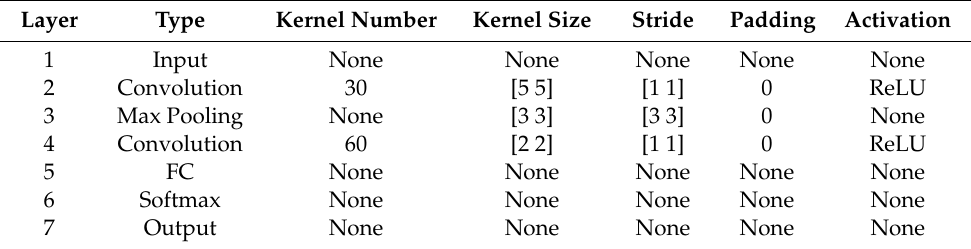
Table 4. Structural parameters of the